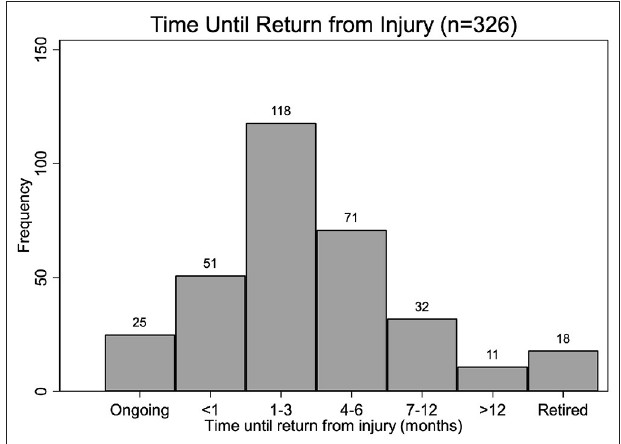
FIGURE 1 | Reported time to return to agility training and competition from iliopsoas injury among 326 dogs.